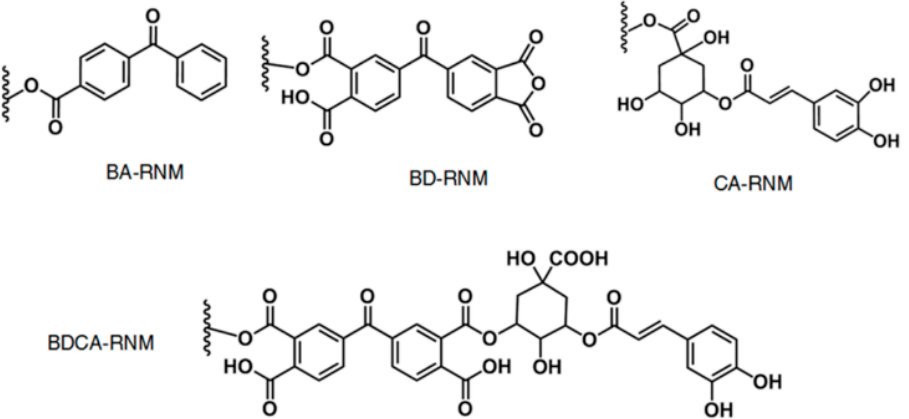
Figure 15. Particles that were tested by Sun et al. Reproduced from Yoon JS, Kim G, Jarhad DB, Kim HR, Shin YS, Qu S, et al. Design, Synthesis, and Anti-RNA Virus Activity of 6 ′ -Fluorinated- Aristeromycin Analogues. J Med Chem 2019;62:6346–62RSC. Reprinted with permission from AAAS